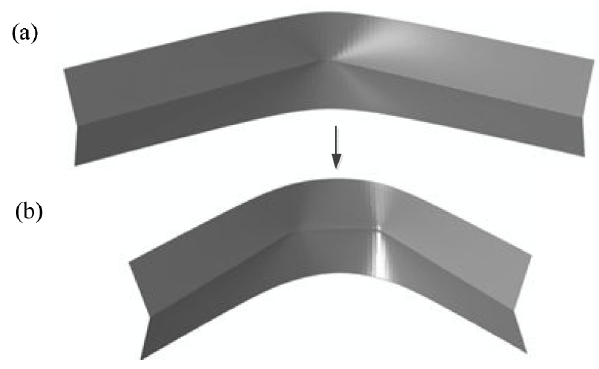
Figure 7. The transformation of localized folding from (a) single fold to (b) double folds.